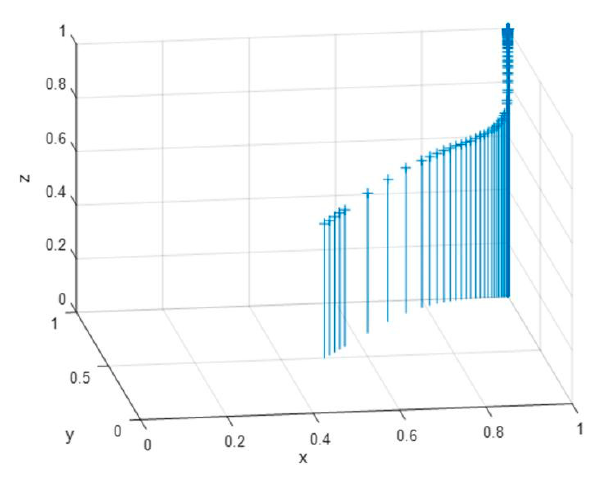
Figure 12. Three-dimensional diagram of evolutionary path at stable point (1, 1, 1).